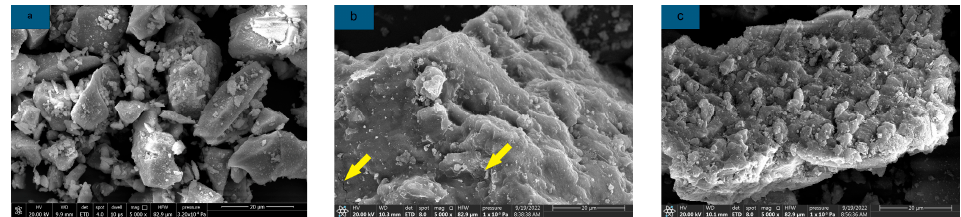
Figure 10. Microstructure of AAS with di ff erent sucrose dosages ( a ) M0; ( b ) S2; ( c ) S6.